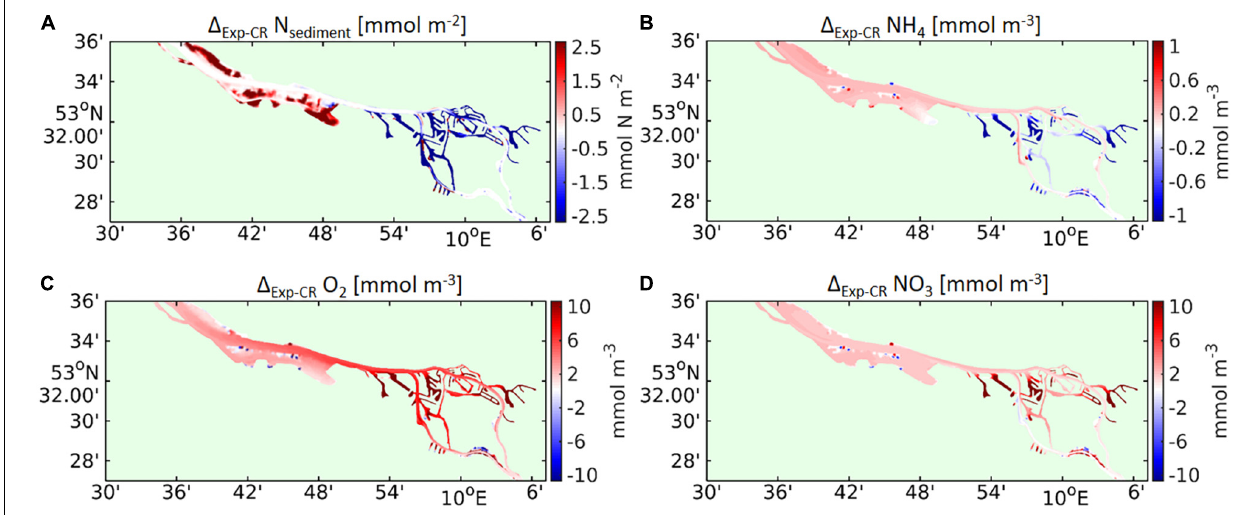
FIGURE 13 | Spatial maps represent the time-averaged differences between the experiment and the control run ( Exp − CR ) of (A) mass per square meter of sediment nitrogen and concentrations of (B) near-bottom ammonium, (C) near-bottom oxygen, (D) near-bottom nitrate whereas near-bottom refers to the lowermost pelagic cell and time-averages represent the period May to September